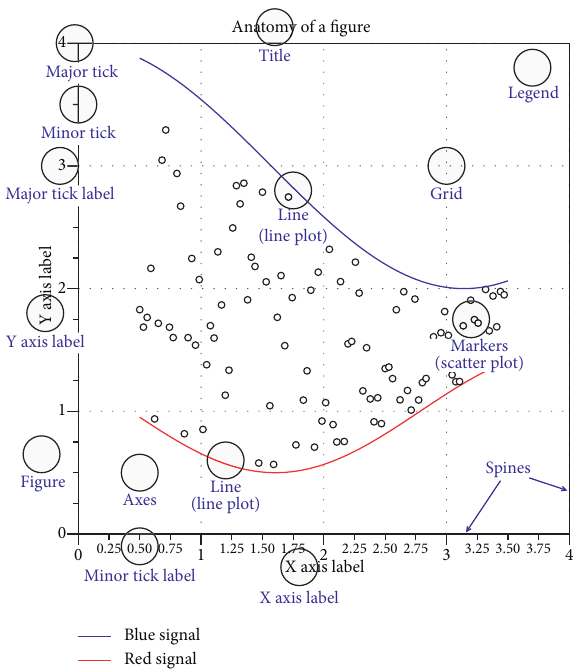
Figure 5: Multidimensional scale analysis